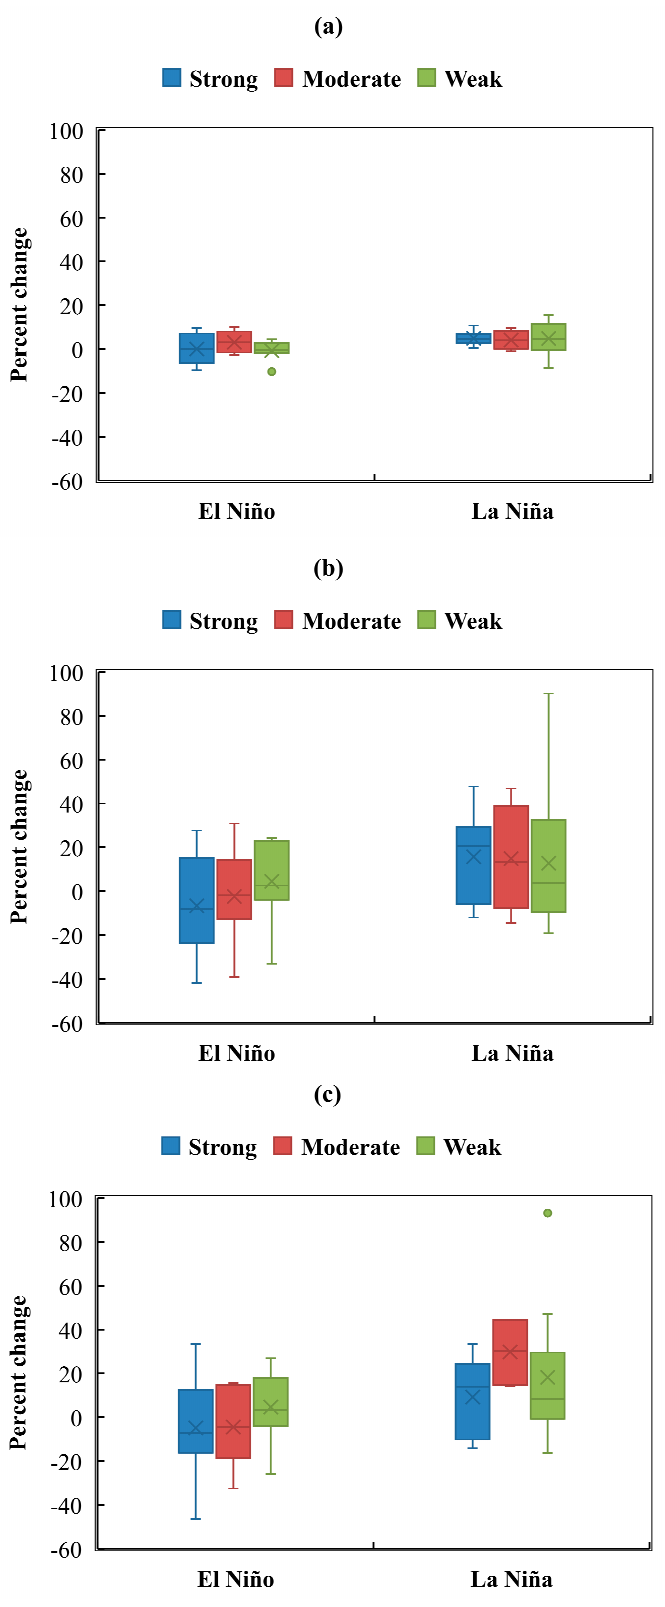
Figure 3. Box plots depicting the percent change in ( a ) average area, ( b ) production, and ( c ) productivity of Kharif rice in Karnataka during El Niño and La Niña years compared to normal years (1963–2016).